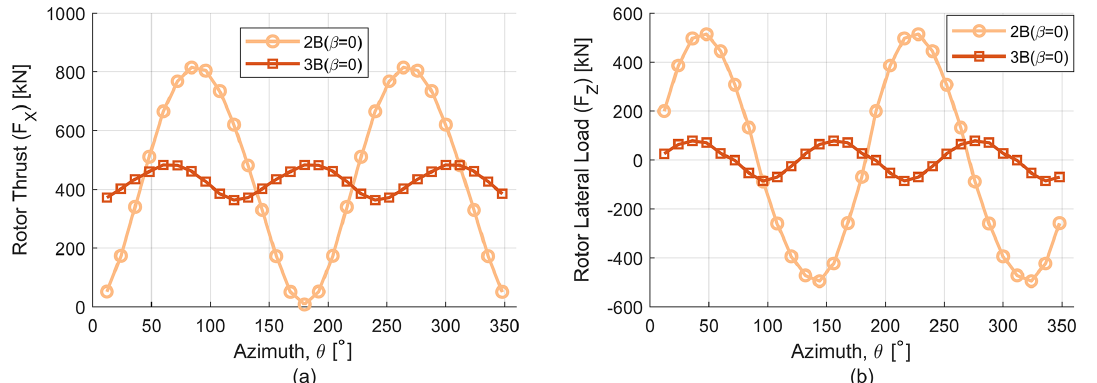
Figure 16. (a) Thrust load ( F X ) for one revolution for two-bladed (2B) and three-bladed (3B) rotors. (b) Lateral load ( F Z ) for one revolution for two-bladed (2B) and three-bladed (3B) rotors.